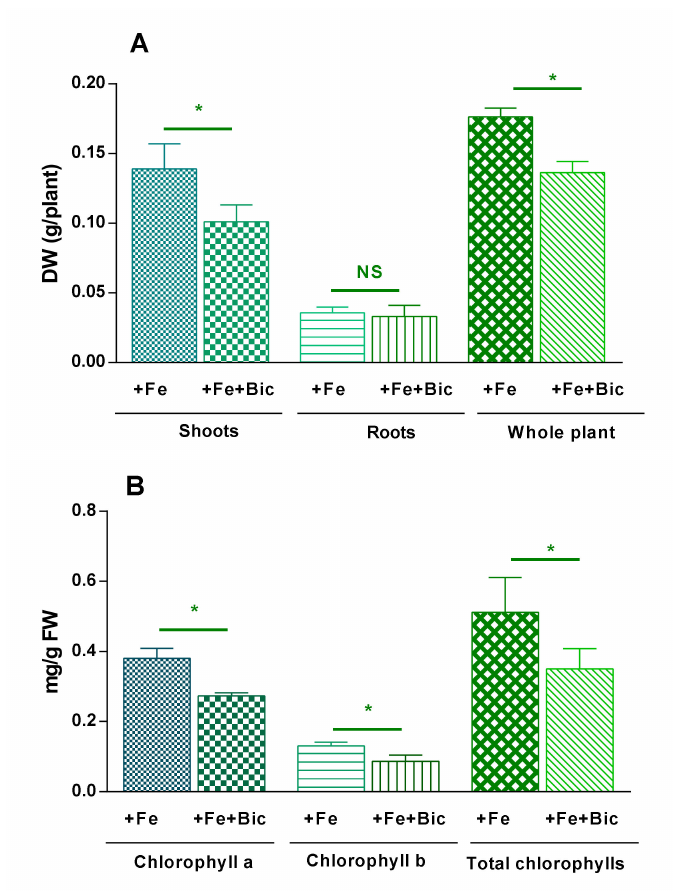
Figure 2. Plant yields ( A ) and levels of photosynthetic pigment in leaves ( B ) of fennel plants grown under Fe sufficiency (+Fe) or under Fe deficiency conditions (+Fe + Bic). DW, dry weight; FW, fresh weight. Data represent the mean ± standard deviation of three independent assays. *represents significant differences at p < 0.05; NS represents no significant differences at p <